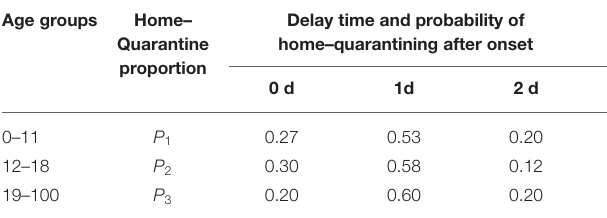
TABLE 2 | The parameters of home-quarantining after onset of